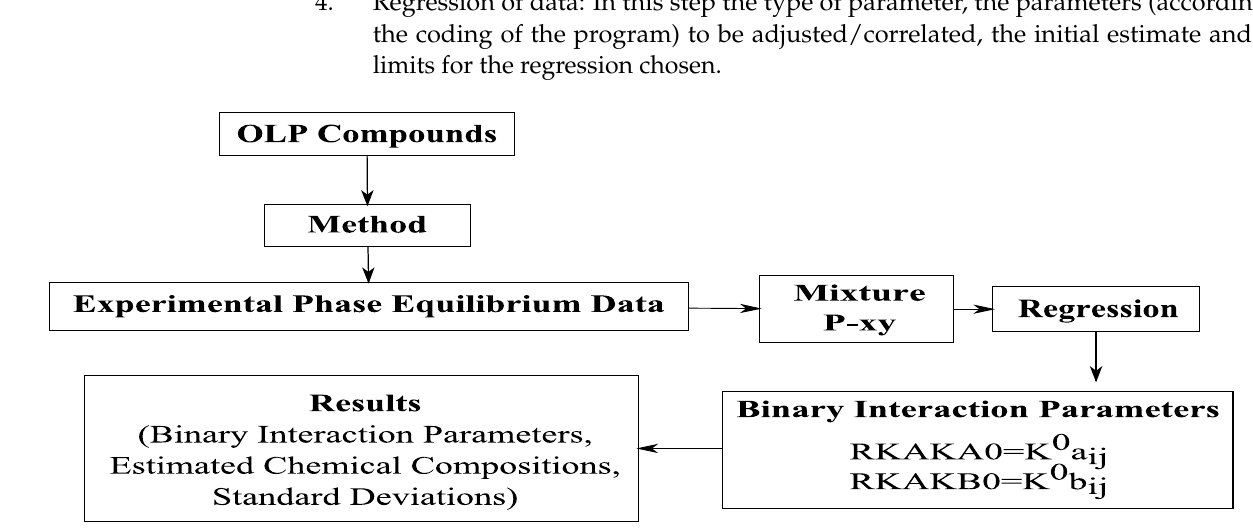
Figure 1. Simplified schematic diagram of the main correlation steps of phase equilibrium data for the binary system organic liquid products compounds- i -CO 2 , and the binary system olive oil key (oleic acid, squalene, triolein) compounds- i -CO 2 , performed by using the Aspen Properties ® .